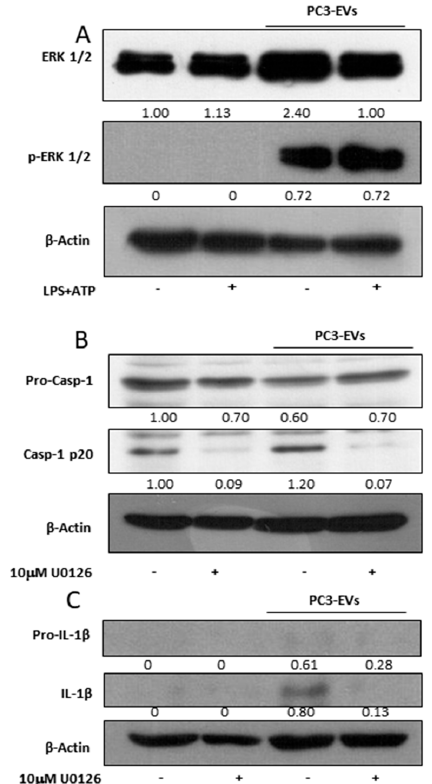
Figure 4. PC3-derived EVs activate caspase-1 via ERK1 / 2. PNT2 cells were treated with 100 µ g / mL of PC3-derived EVs (PC3-EVs) for 24 h ( A ) in the presence or in the absence of 10 µ g / mL LPS + 5 mM ATP (LPS + ATP) and the expression of phosphorylated ERK1 / 2 was analyzed by Western blotting. PNT2 cells were pretreated for 1 h with 10 µ M U0126 and then treated for 24 h with 100 µ g / mL PC3-EVs. ( B ) caspase-1 full length and mature caspase-1-p20 expression and ( C ) pro-IL-1 β full length and mature IL-1 β -p20 expression were evaluated in total extract analyzed by Western blotting. β -actin was used as a loading control. The images are representative of one out of n = 3 separate experiments. Numbers below the images represent the ratio between the respective protein and β -actin band